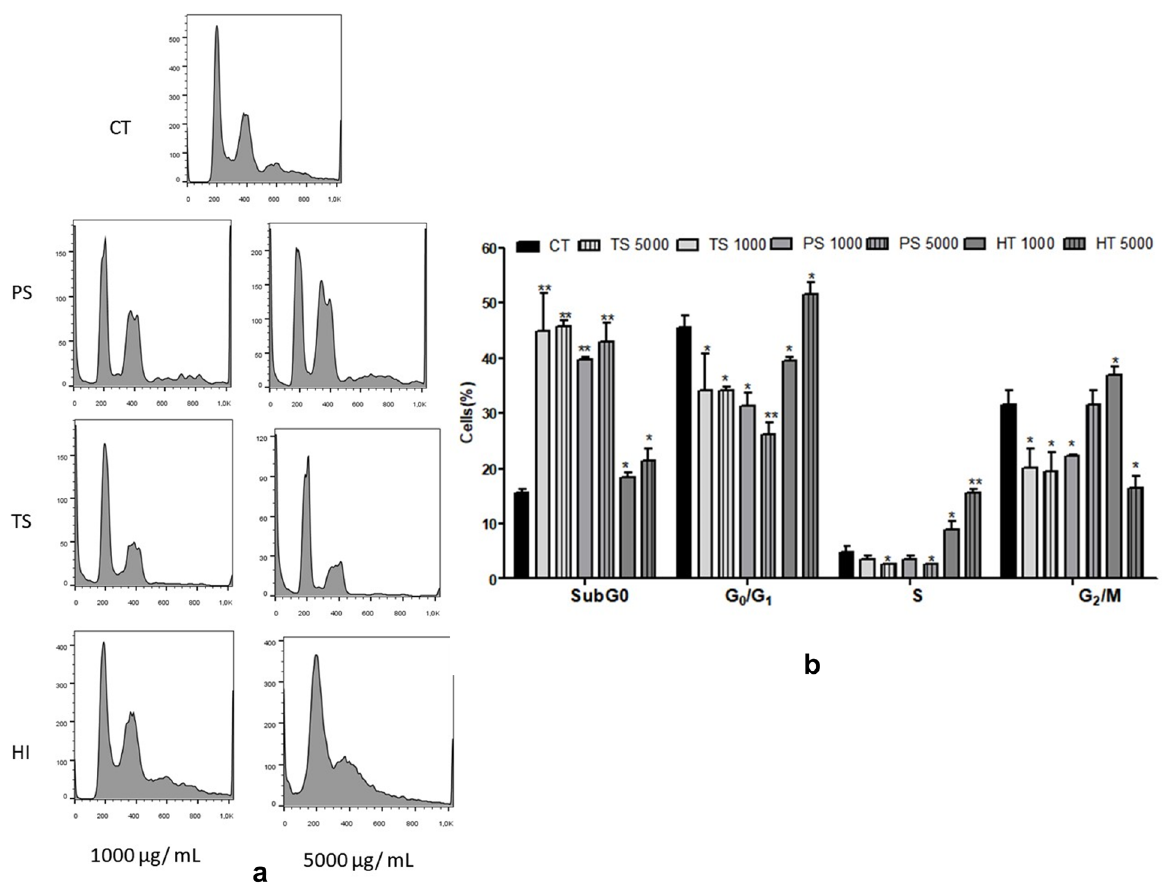
Figure 3. Effect of 48h incubation of MDA-MB 435 cells with 1000 and 5000 μg/ mL Pedro Sato (PS), Tsumori (TS) and Hitígio (HI) guava cultivar extracts on cell cycle progression. Cell cycle phases are illustrated in (a). Quantitative results are shown in graph (b). Results are expressed as mean ± standard deviation of two experiments. Significant differences between untreated (CT) and treated cells were compared by One- way ANOVA followed byTukey test Significant differences are indicated as * p<0.05 and ** p